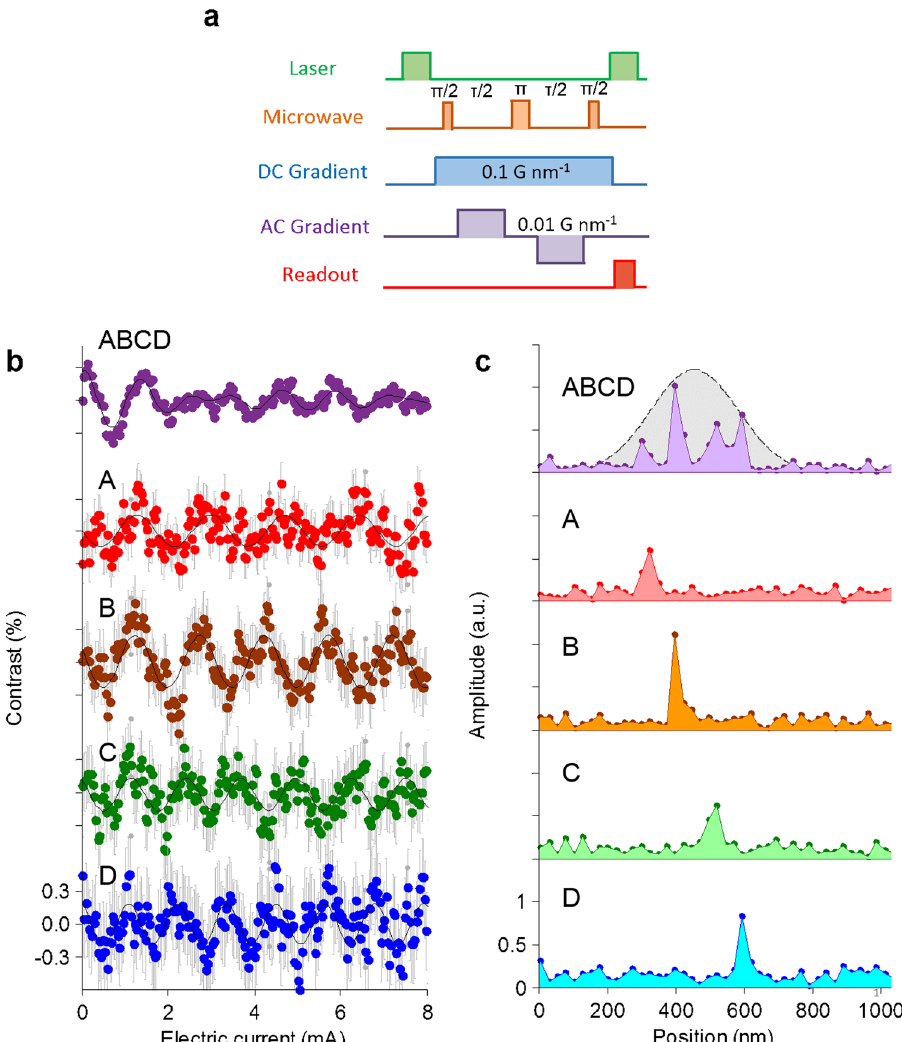
Fig. 3 Site-selective NV Fourier imaging with nanoscale resolution. a Site-selective NV Fourier imaging sequence. NV spin states are initialized and read out with green laser pulses. A microwave Hahn echo ( π /2 – π – π /2) pulse sequence, synchronized with an alternating (AC) magnetic fi eld gradient (amplitude ~0.01 G nm − 1 ), causes NV spins to acquire position-dependent phase shifts, while also decoupling the spins from environmental noise. A fi xed (DC) fi eld gradient (0.1 G nm − 1 ) differentiates the ESR frequencies at the four NV sites via Zeeman frequency encoding. b 1D k -space images of the four NV sites. The AC gradient strength and hence the wavenumber k are incrementally stepped by varying the current amplitude through the microcoil. The NV fl uorescence is normalized to a reference measurement of the | 0 〉 state fl uorescence, and a constant background level is subtracted. The top data set (labelled ABCD) is measured without the DC gradient, and thus all four NV sites are represented in the k -space image. The bottom four data sets A, B, C, and D are measured with the DC gradient applied and the microwave frequency tuned to select only one each of the four NV sites. For all fi ve k -space images, the solid black curves are fi ts of the data to a simple sinusoid model. Error bars indicate 68% con fi dence intervals. c 1D real-space images of the four NV sites, obtained from the absolute value of the Fourier transforms of the k -space data. As with the k -space images, the top real-space image (ABCD) is with no DC gradient, and thus all four NV sites are represented, whereas the bottom four images A, B, C, and D are with the DC gradient applied and the microwave frequency tuned to select only one each of the four NV sites. For comparison, the diffraction-limited, real-space point spread function of the confocal microscope is shown ( grey shaded area , full-width at half-maximum of 300 nm). The location of each NV site determined from the site-selective images A, B, C, and D agrees well with that obtained by Fourier imaging of all four sites without the DC gradient